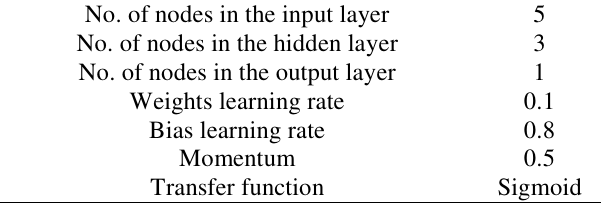
Table 4. Architecture and specification of the generated ANNs